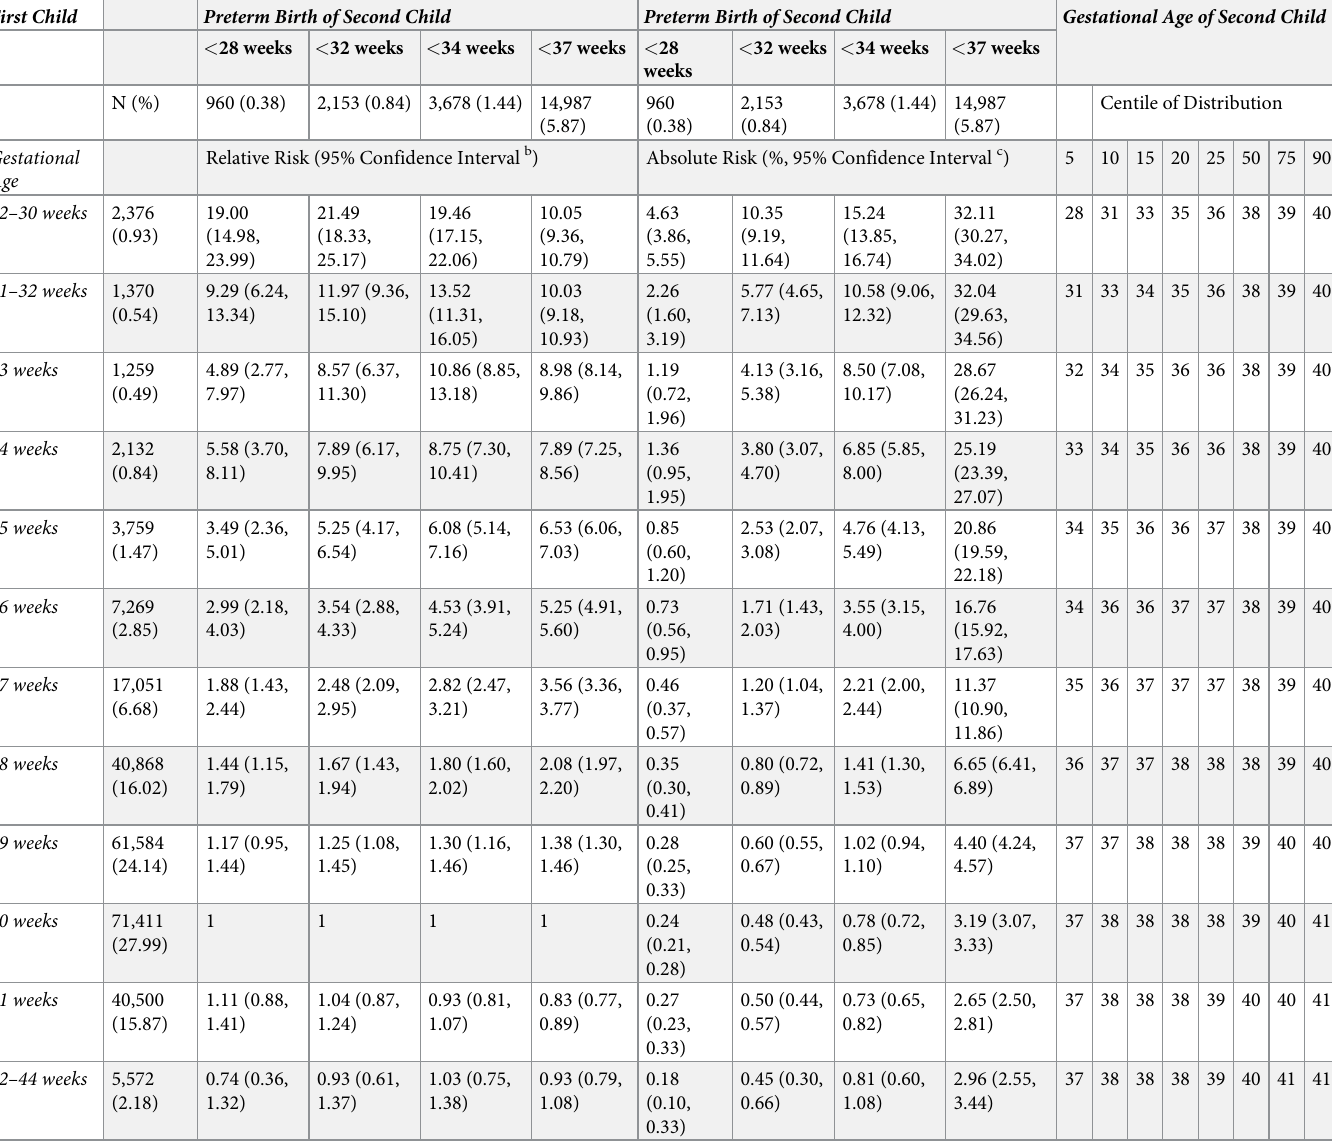
Table 2. Relative and absolute risk of preterm birth of the second child a by gestational age of the first child for the study population for mothers who gave birth to their first two singleton children between 1980 and 2015 in Western Australia (N = 255,151 mothers). First